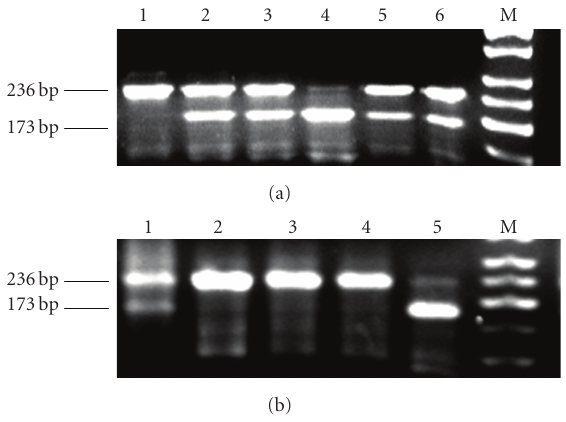
Figure 1: Polymorphisms and imprinting of the IGF-II gene in the placenta. (a) polymorphisms of IGF-II: 1 had type AA homozygosity; 4 had type BB homozygosity; 2,3,5,6 had type AB heterozygosity; and M, marker. (b) imprinting of IGF-II: 1, loss of imprinting AB; 2–4, normal imprinting A; 5, normal imprinting B; and M,